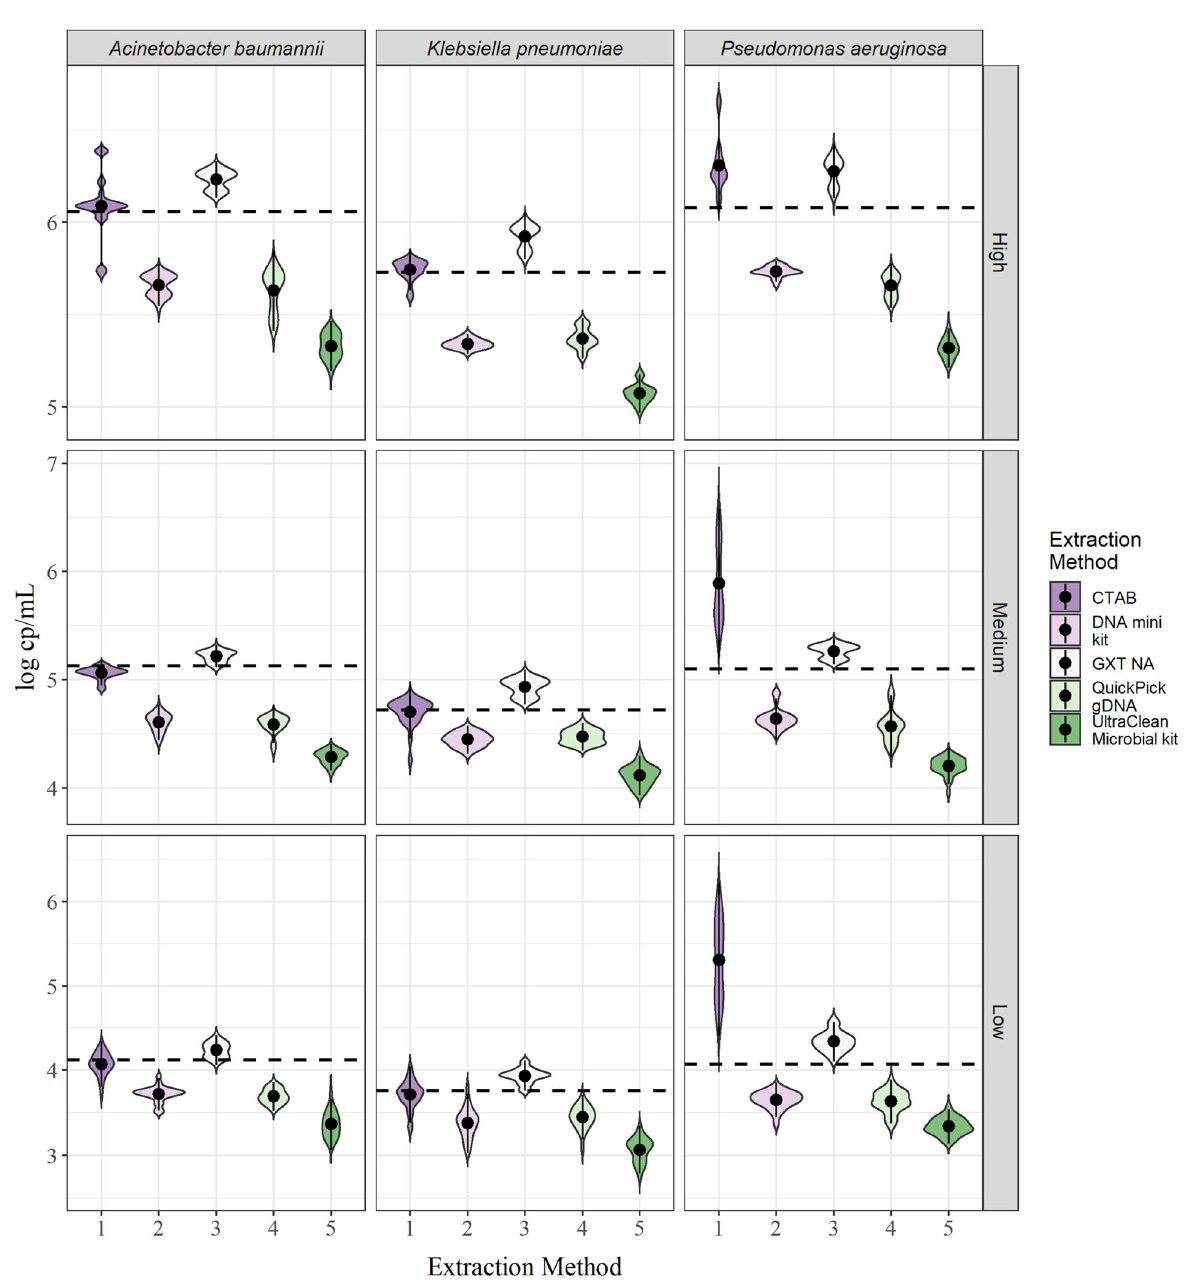
Figure 2. Yields of DNA biomarkers for each of the target bacteria and DNA extraction methods. The dotted line represents the theoretical 100% yield. Table 1. Bias to the theoretical 100% yield (based on direct dPCR) across the extraction systems for all three target